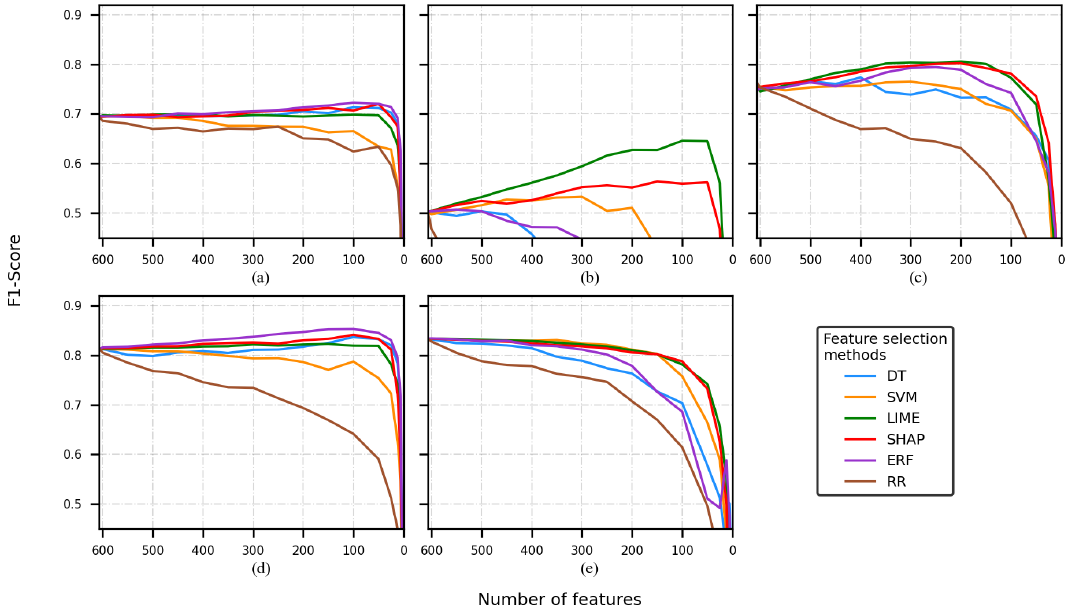
Figure 3. F1-score of the model is obtained by using a different number of features, using the Siena dataset and FS1. Classification model used: ( a ) decision tree, ( b ) support vector machine, ( c ) artificial neural network, ( d ) random forest, and ( e ) K-nearest